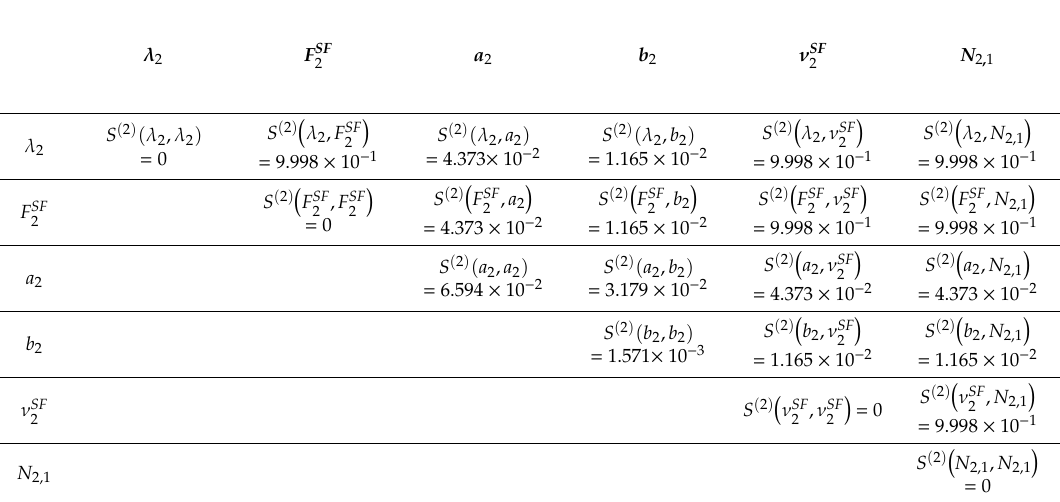
Table 6. 2nd-order relative sensitivities S ( 2 ) respect to the source parameters of isotope 240